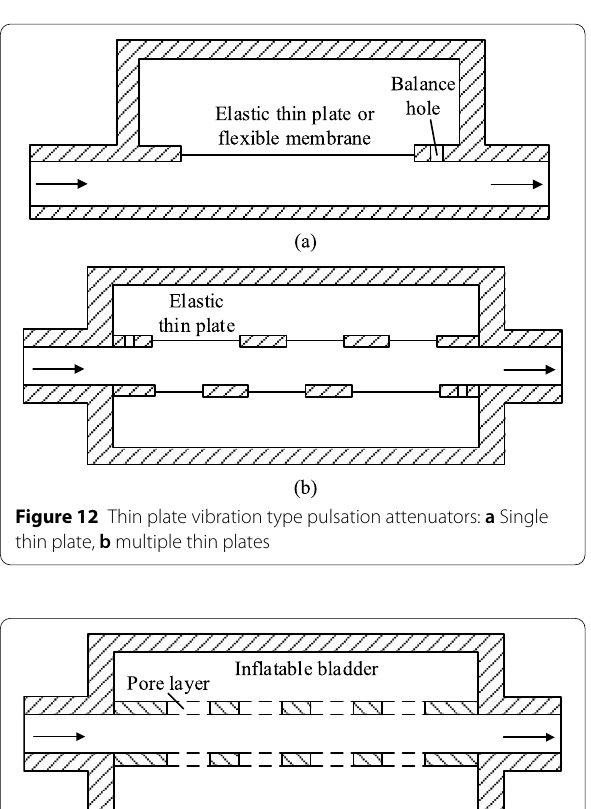
Figure 13 Inflatable bladder type pulsation